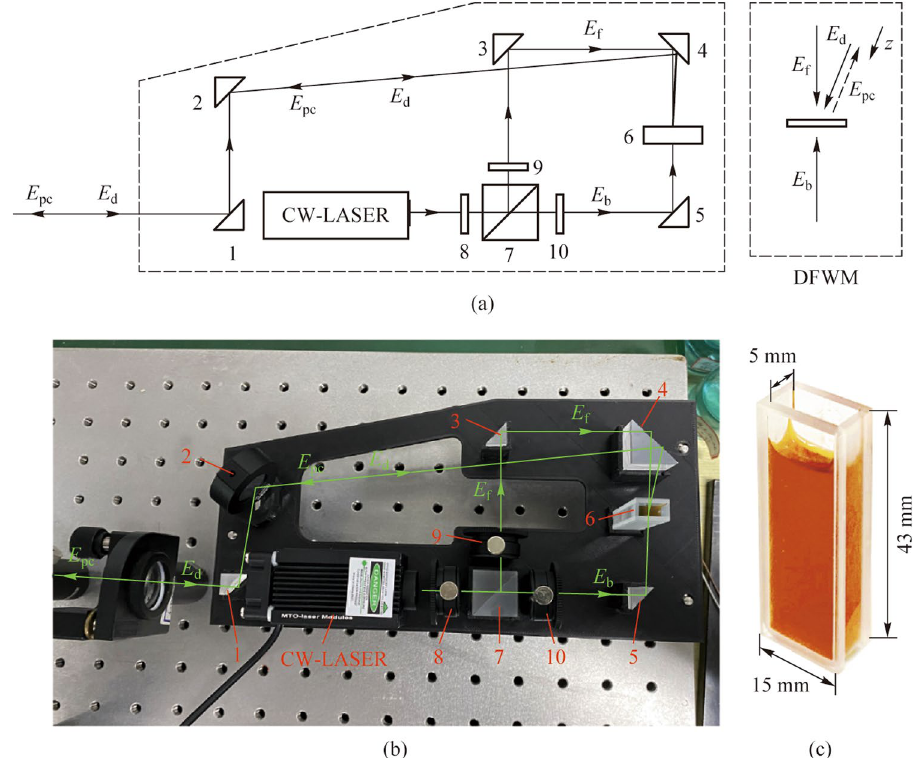
Fig. 1 a Schematic of the PCM. E f , forward pump beam; E b , backward pump beam; E d , distorted beam, and E pc , phase-conjugate beam; CW- laser is a 532-nm CW laser; 1 − 5 are mirrors; 6 is the NLO medium; 7 is PBS; 8 − 10 are HWP. b Experimental setup for the PCM. c NLO medium in a